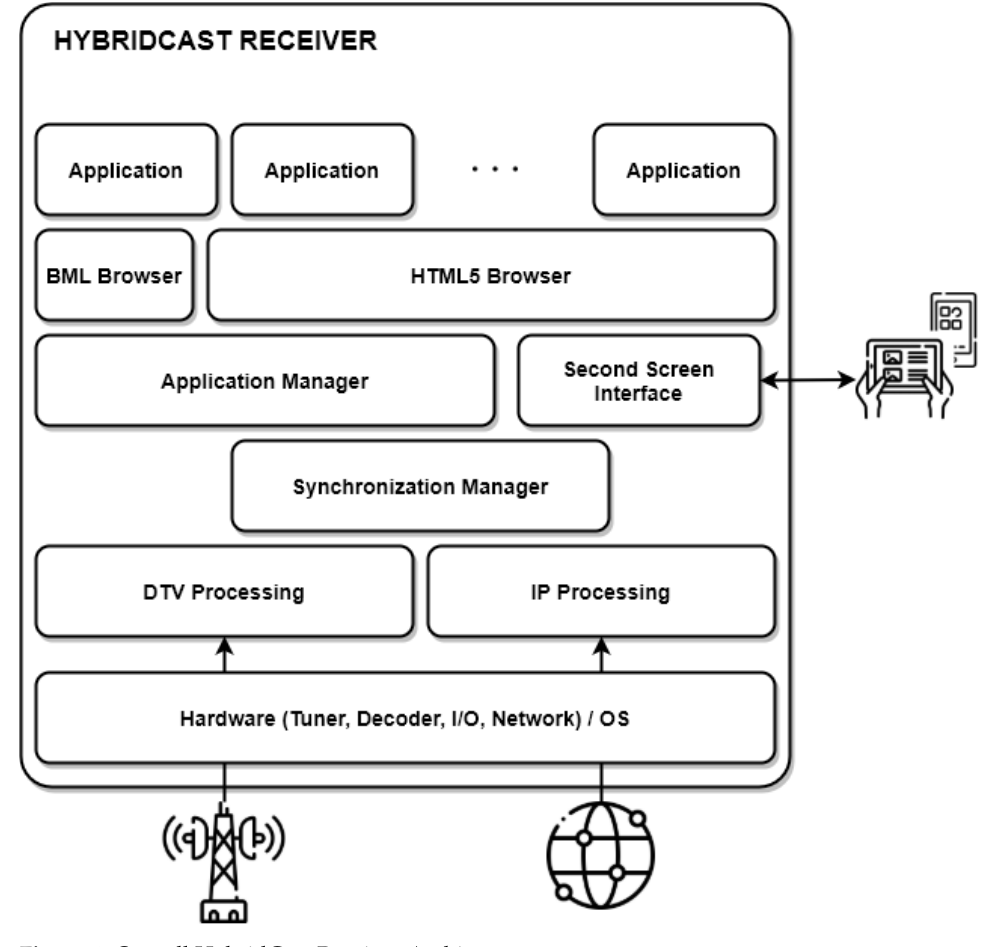
Figure 4. Overall HybridCast Receiver